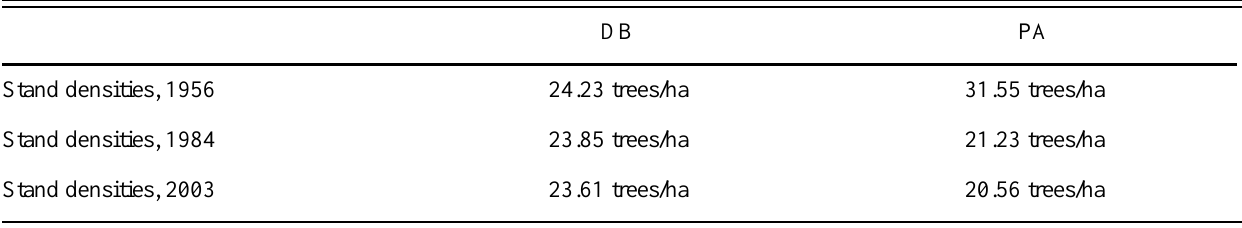
Table 3 . Changes in stand densities, 1956–2003. DB is the Dehesa Boyal site, and PA is the Parapuños de Doña María